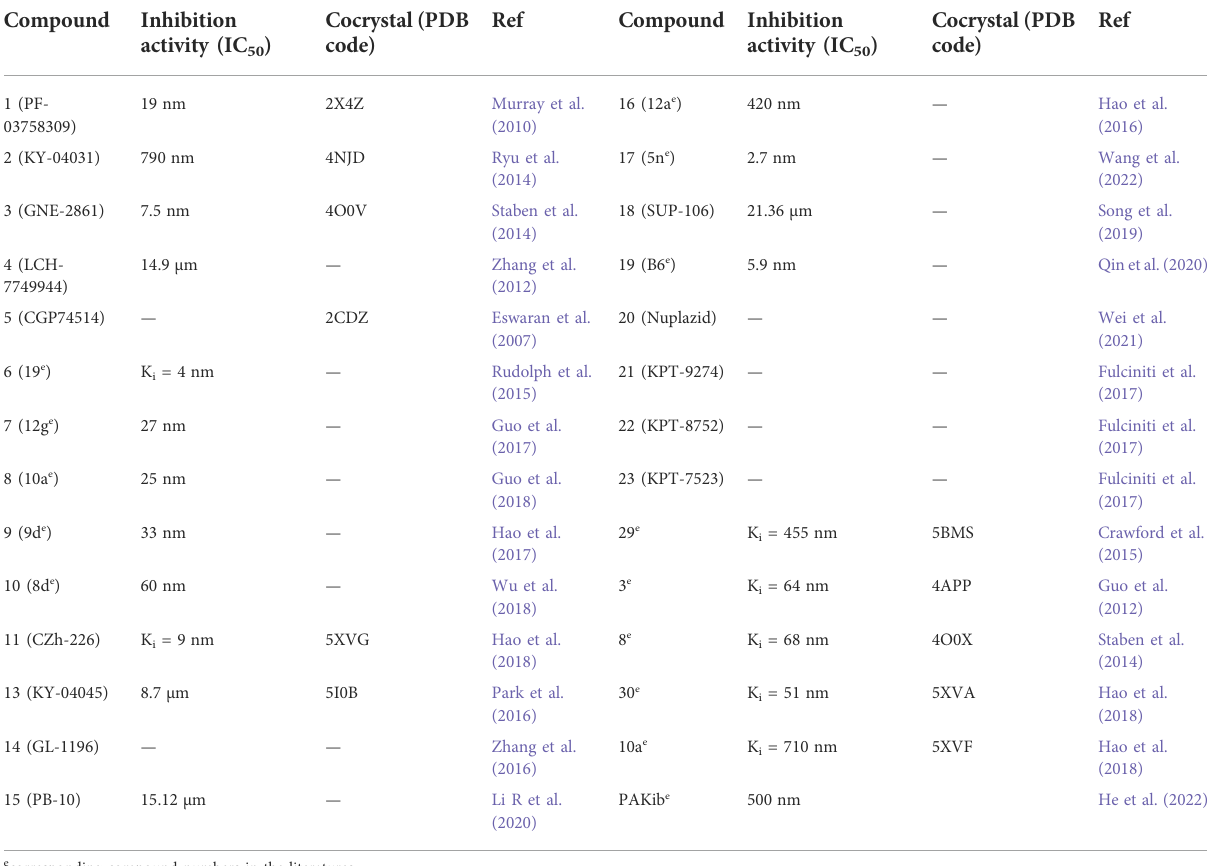
TABLE 1 Summary of the PAK4 inhibitors.